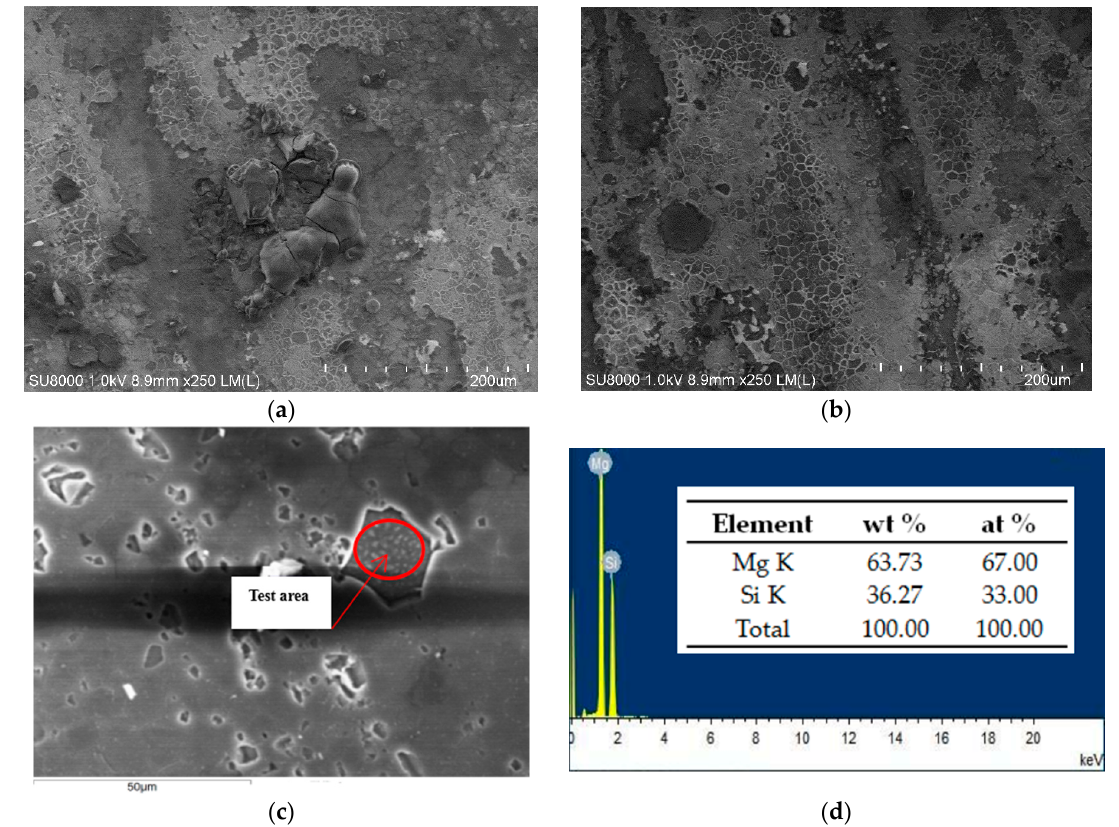
Figure 14. SEM images ( a , b ) of the dendrites on the edge of the as-cast AZ61 magnesium alloy with different magnifications, respectively.